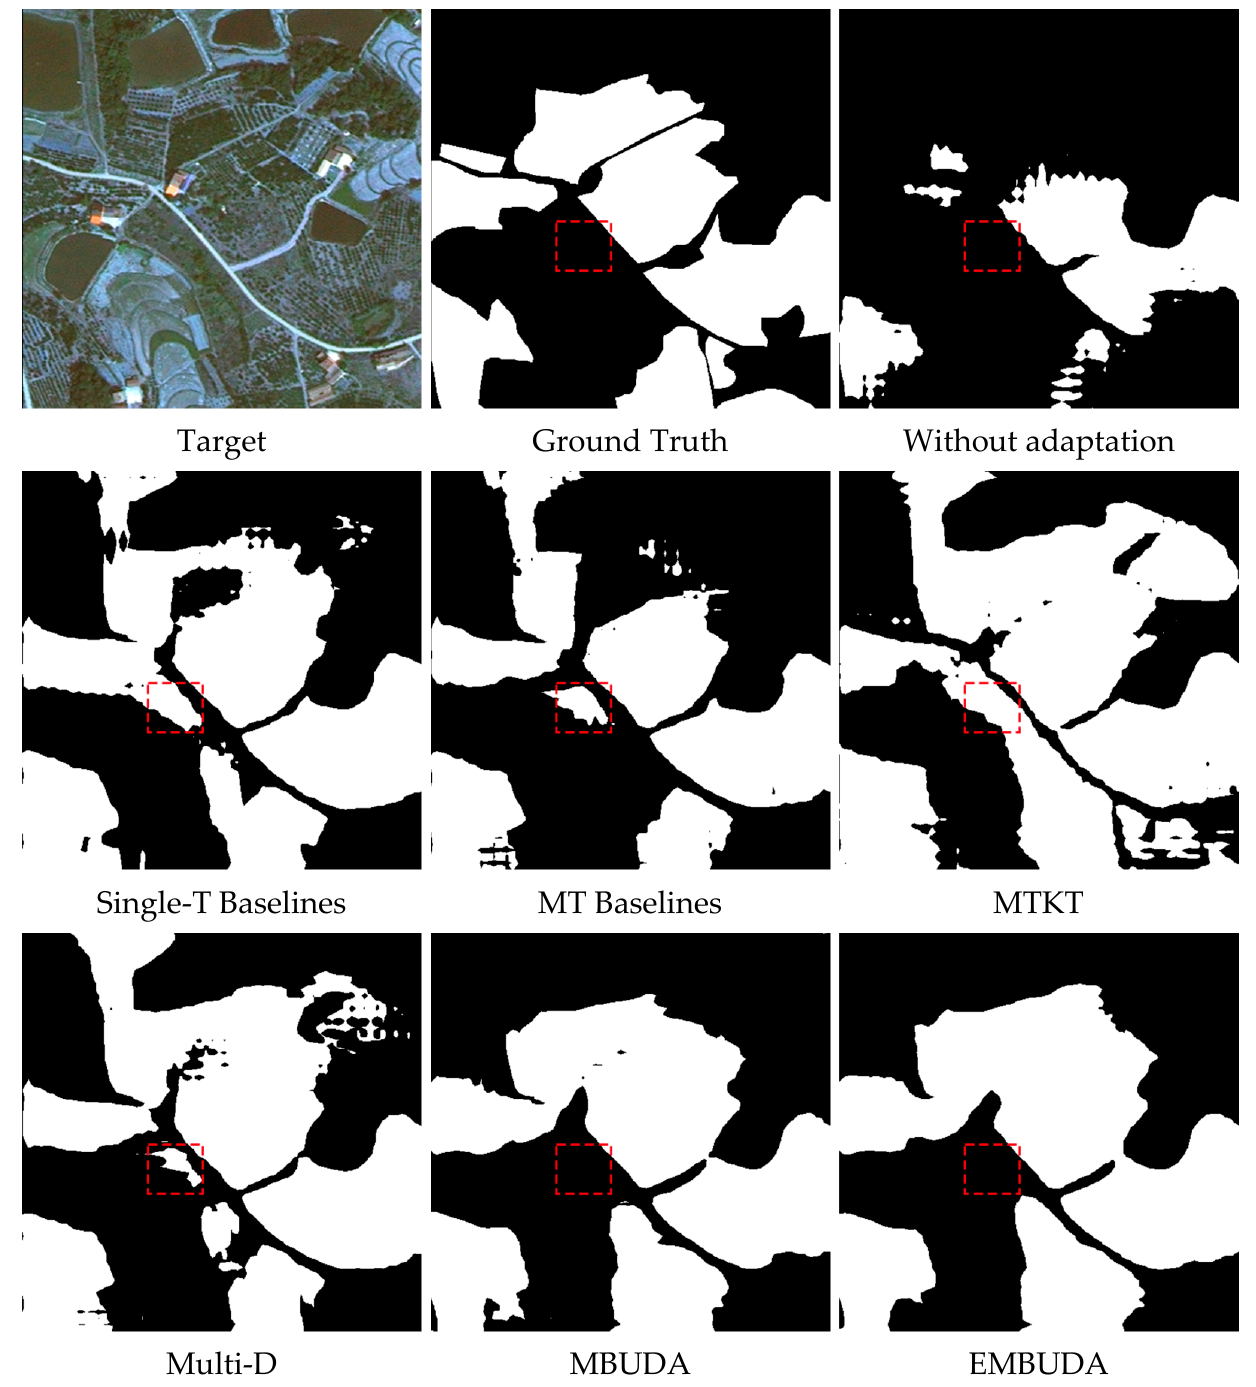
Figure A9. Outputs of orchard area segmentation in Dataset XT2 when adapting from Dataset CY to Dataset ZG, Dataset XT1 and Dataset XT2.